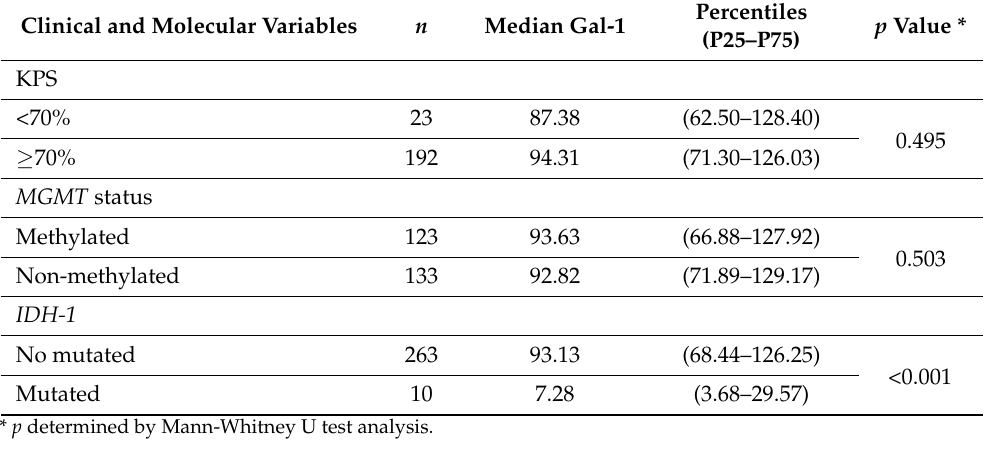
Table 2. Correlation between Gal-1 mean expression and relevant clinical and molecular data (Karnofsky Performance Status (KPS), O(6)-methylguanine-DNA methyltransferase ( MGMT ) status, isocitrate dehydrogenase 1 ( IDH-1 ).